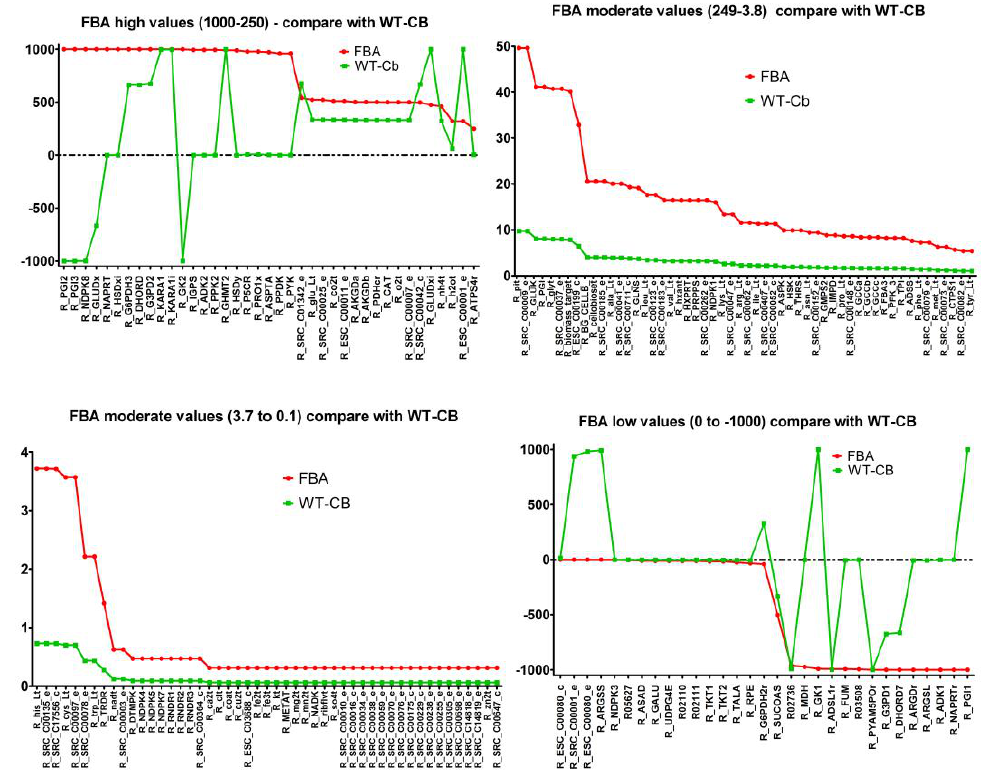
Figure 2. Comparison of metabolic pathways with high, medium, low, and negative fluxes between FBA simulations (red) and metabolomics-integrated simulations (green).